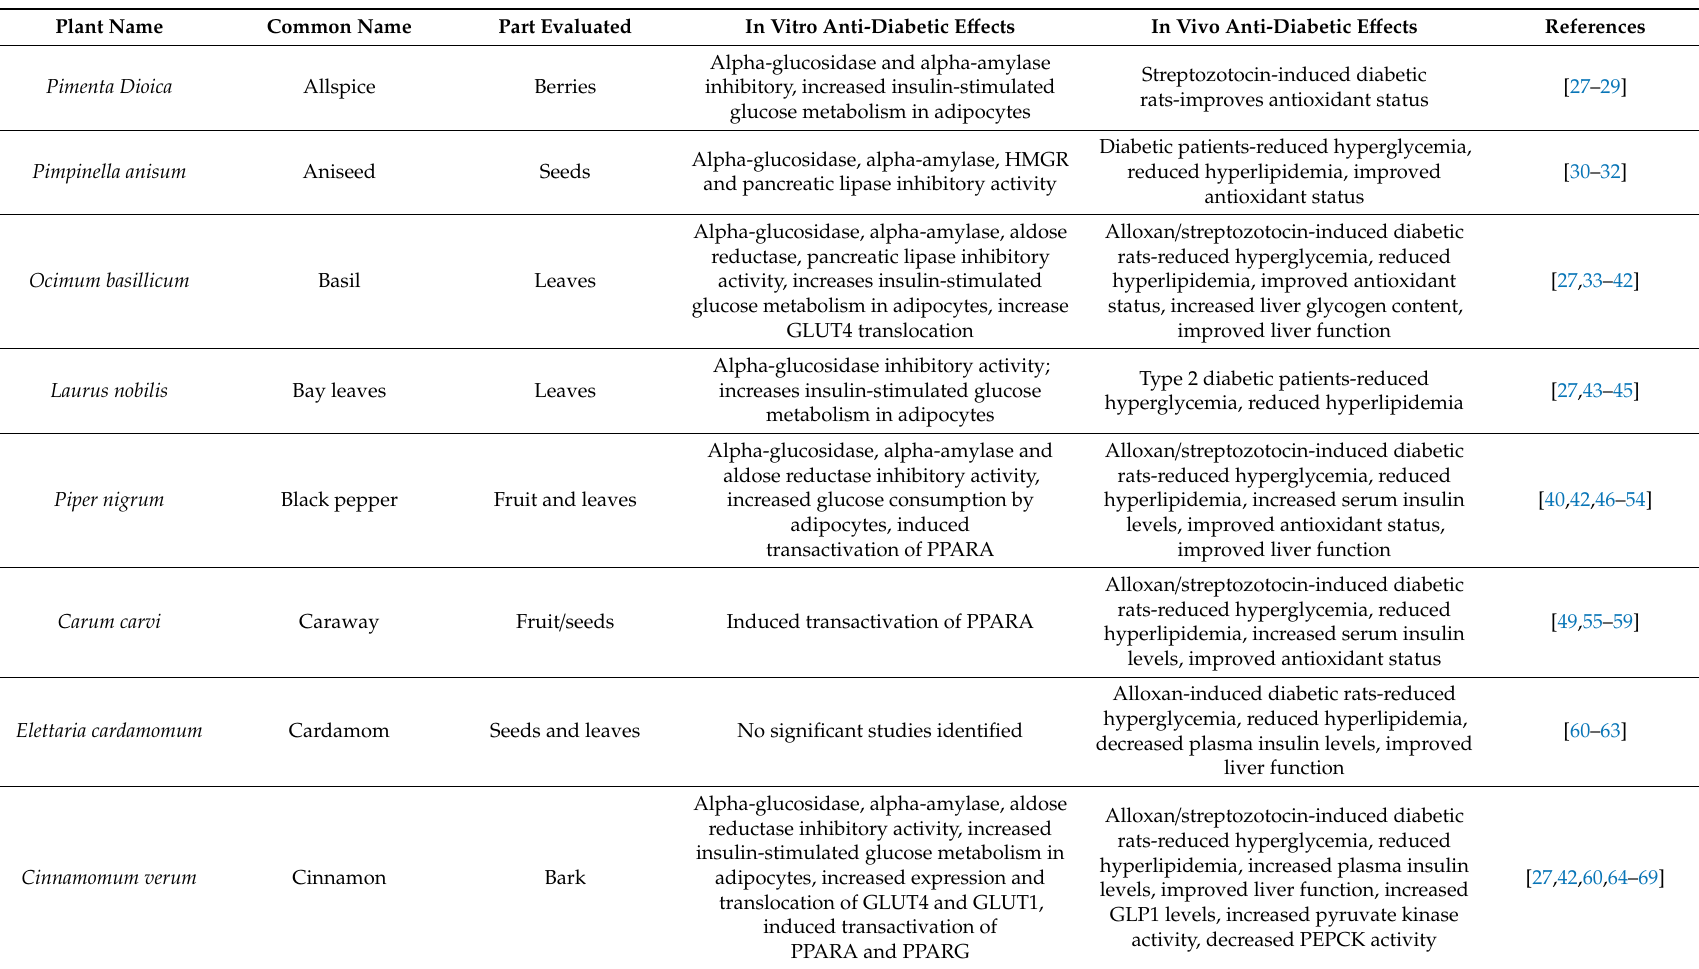
Table 1. Literature review on the in vitro and in vivo anti-diabetic activity of various herbs and